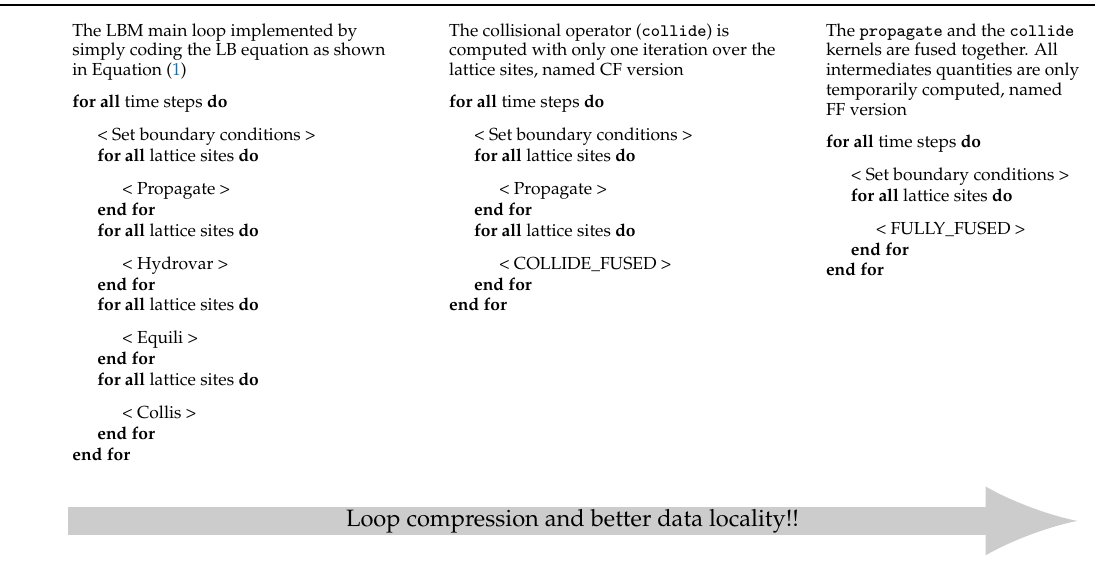
Algorithm 1: Schematic description of the LBM main loop